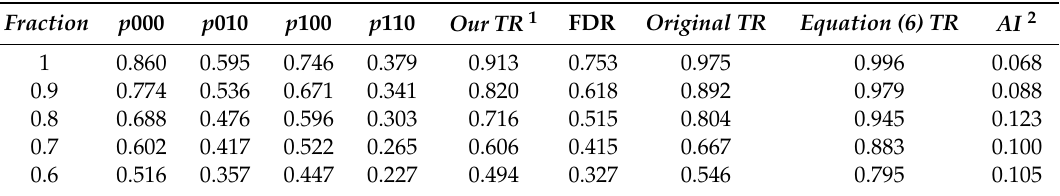
Table 1. Accuracy